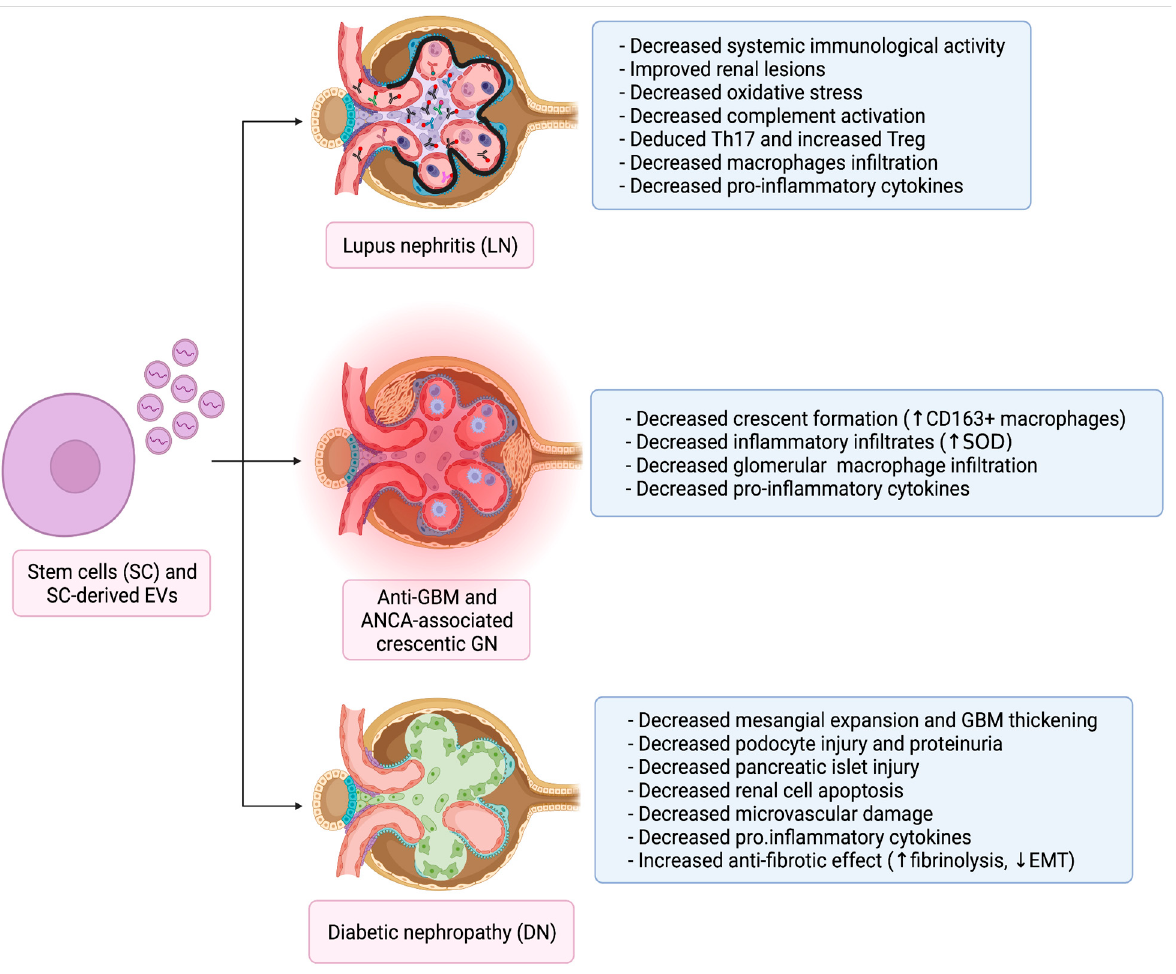
Figure 3. Stem cells and EVs as therapeutic tools for secondary GN (Created with https://bioren- der.com).